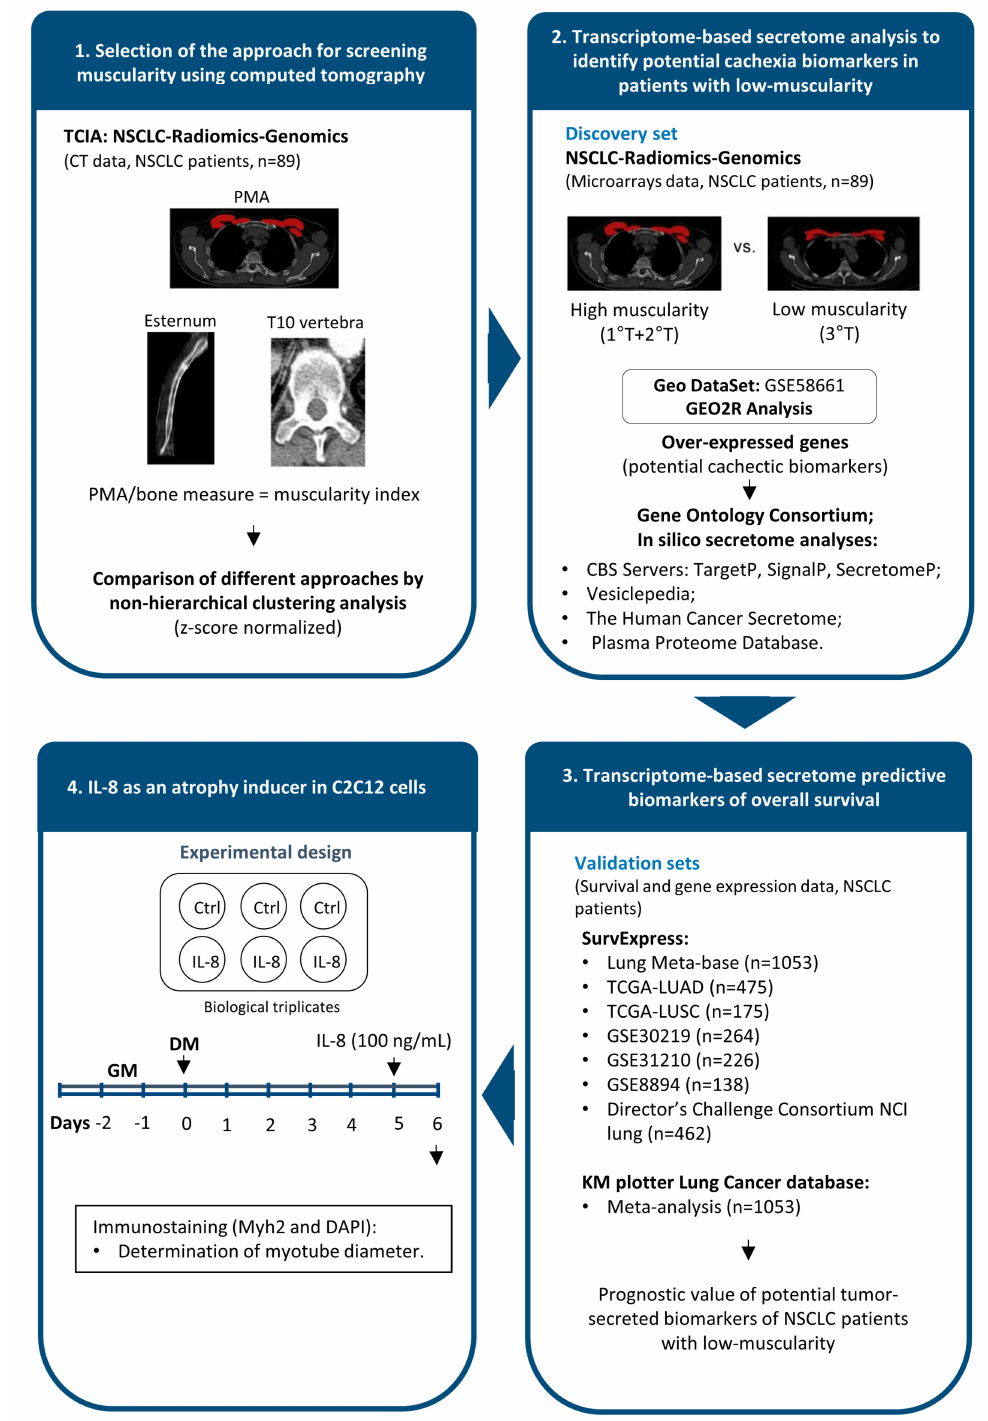
Figure 1. The workflow of the integrative analyses of computed tomography (CT) images and tumor transcriptome data to identify secreted cachexia biomarkers in non-small cell lung cancer (NSCLC) patients with low-muscularity. ( 1 ) We selected CTs from 89 patients with NSCLC from “NSCLC-Radiomics-Genomics” collection [28]. A total of 12 CTs features, including pectoralis muscle area (PMA), manubrium, and sternum body lengths, six T10 (tenth thoracic) di ff erent measures, and an anteroposterior length were used to determine an approach for screening muscularity. ( 2 ) This